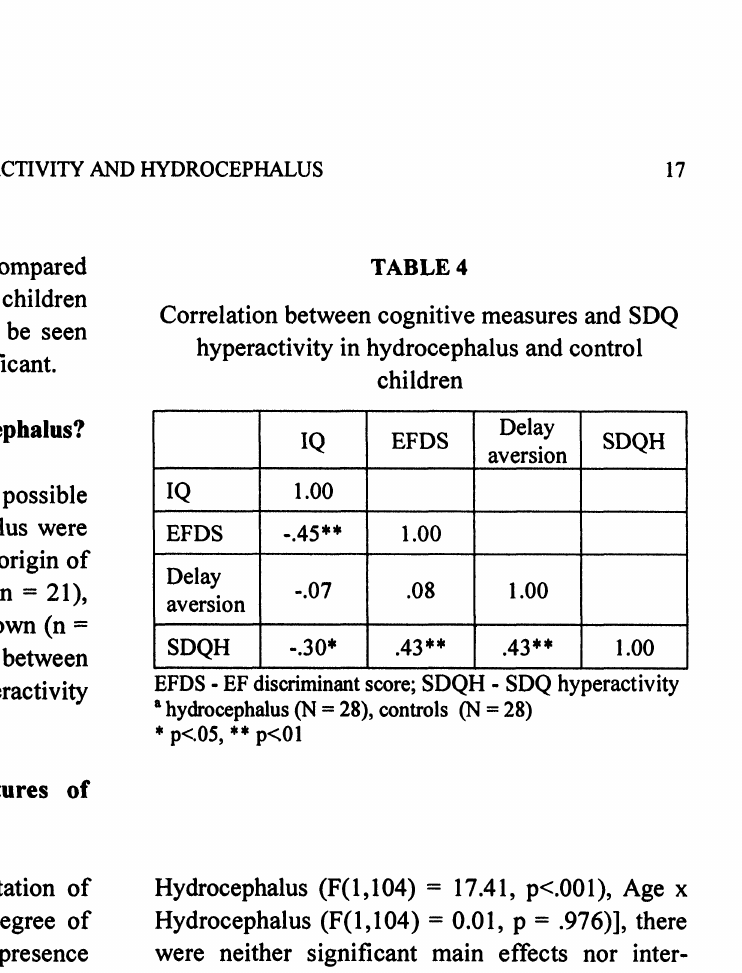
Correlation between cognitive measures and SDQ hyperactivity in hydrocephalus and